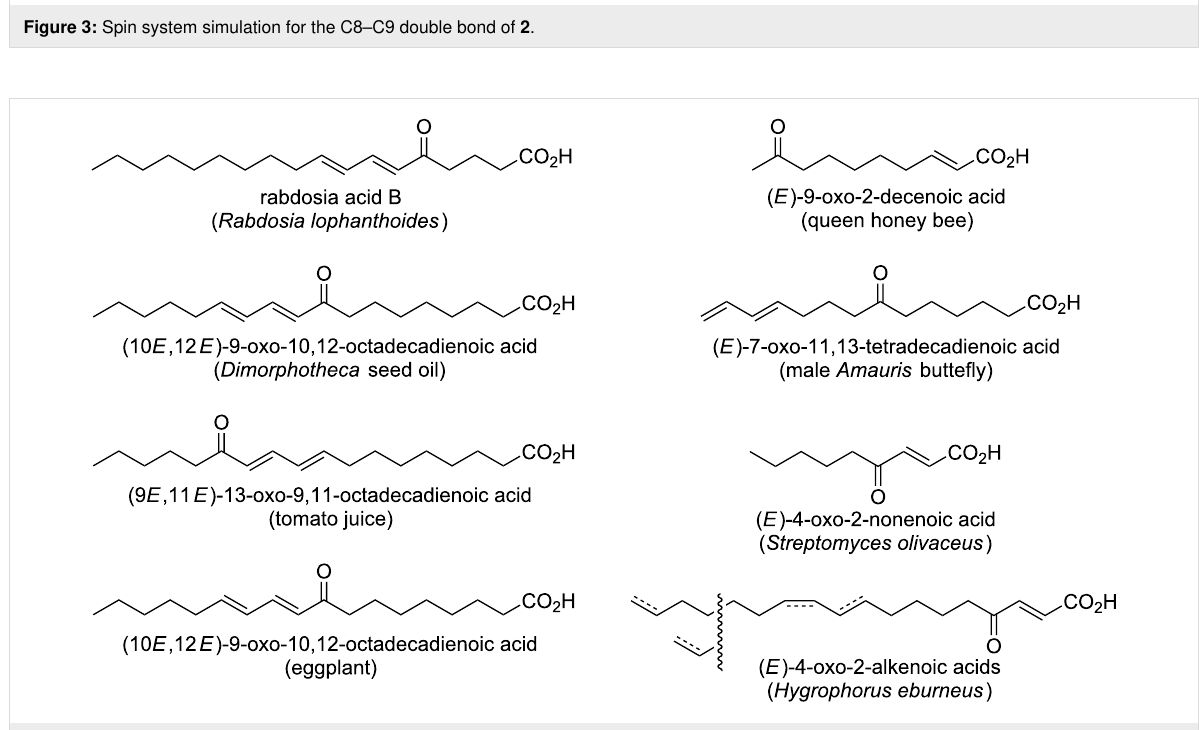
Figure 4: Natural keto fatty acids of various